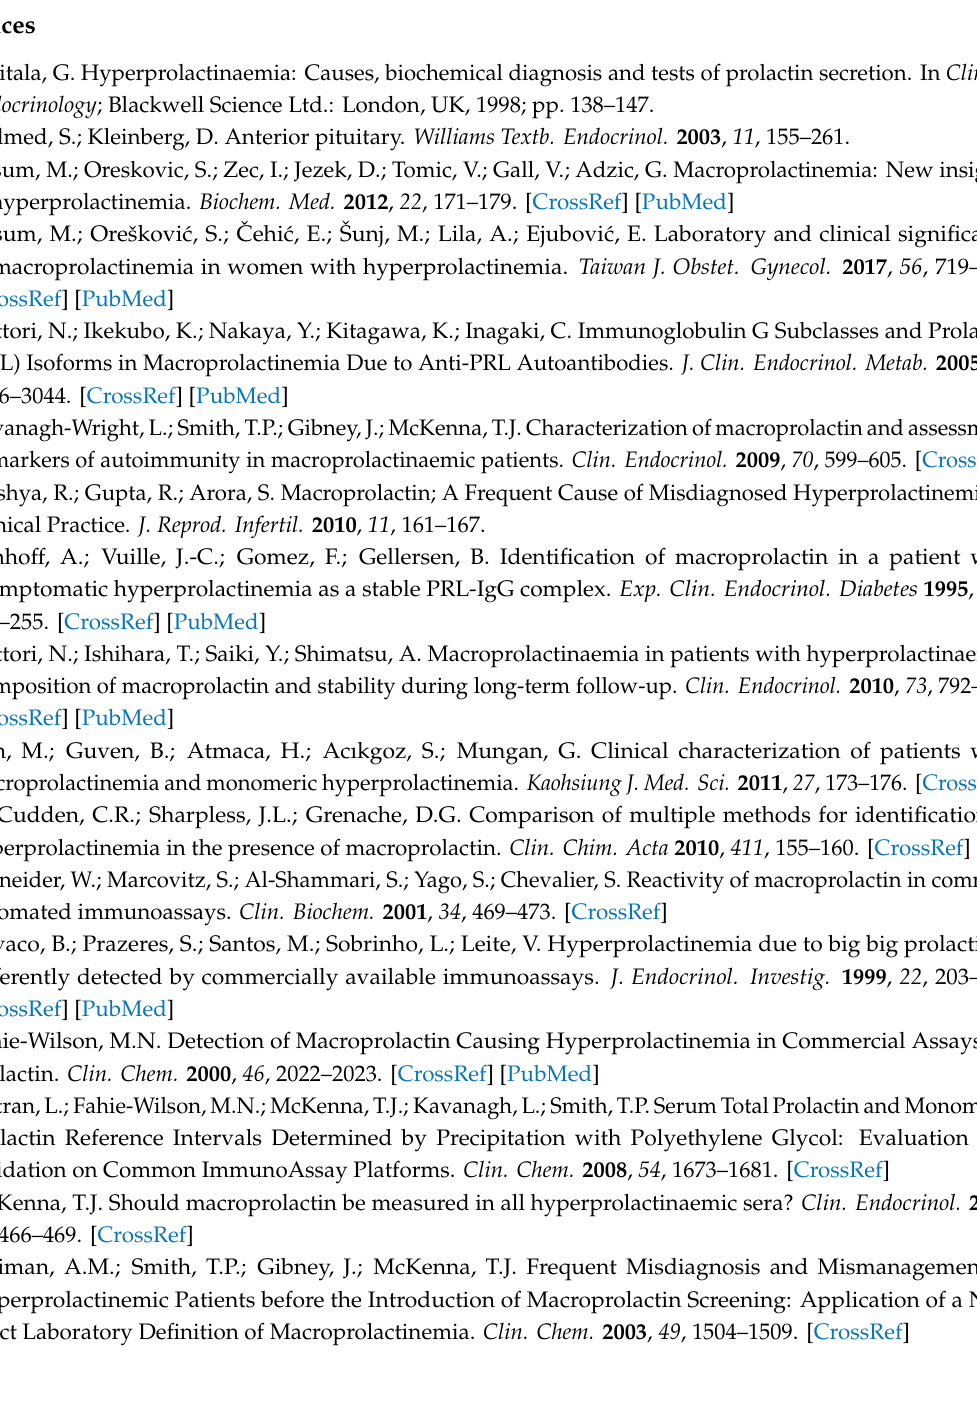
Supplementary Table S1: “Leave-one-out” sensitivity analysis for the meta-analysis on the prevalence of macroprolactinemia among patients with